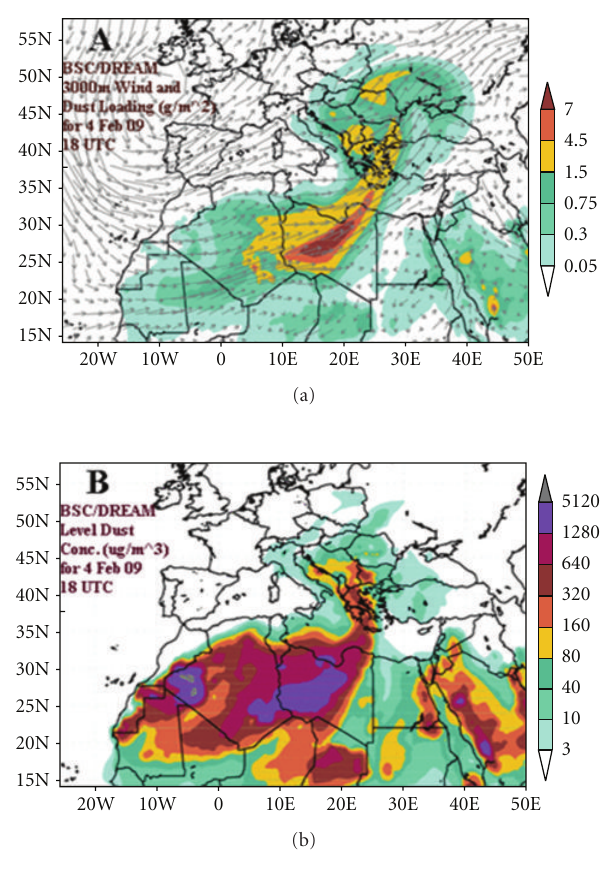
Figure 4: DREAM predictions of dust loading (a) and dust mass concentration (b) on 4 February 2009 for 18:00